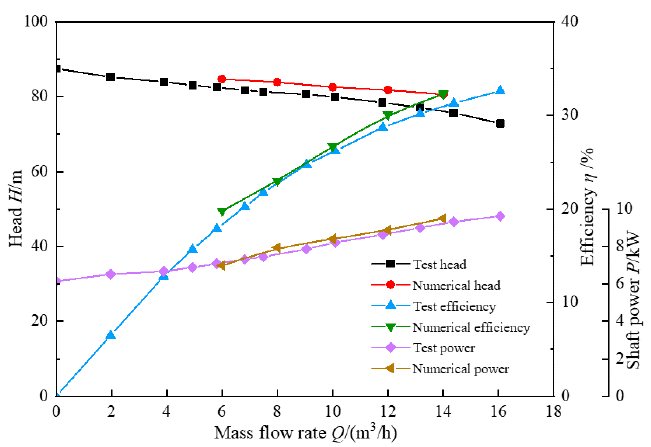
Figure 8. Comparison between simulation results and test results.